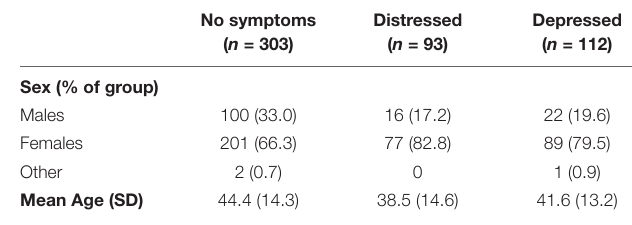
TABLE 3 | Rate of distress and depression by